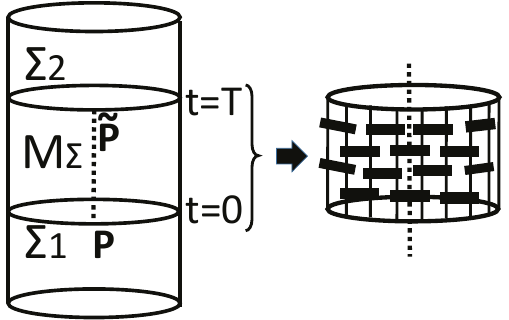
Figure 12 . An example of entanglement evolution in a time-like path-integral in a Lorentzian setup. In the left picture describes its gravity analysis. The right picture is a sketch of its dual quantum circuit, where the vertical lines represent qubits and the thick horizontal intervals denote the unitary quantum gates. We count the number of gates which intersect with the dotted vertical